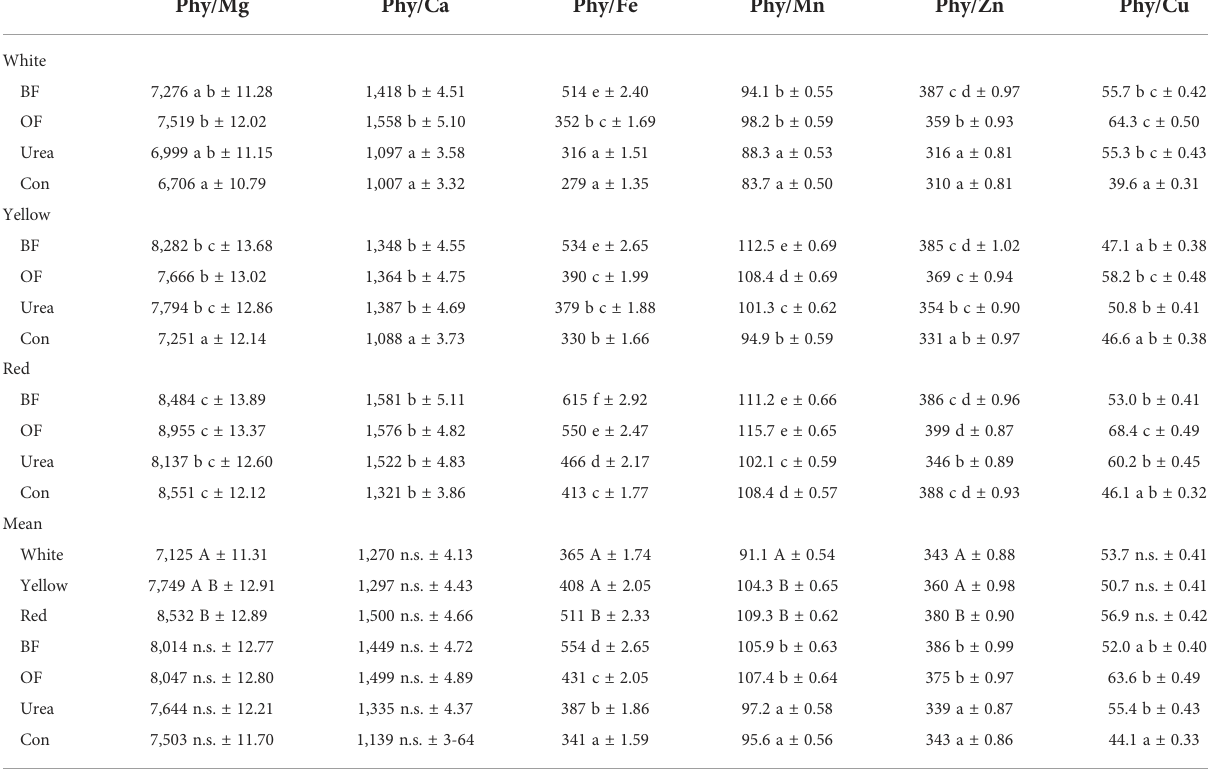
TABLE 6 Effect of different fertilizer treatments (biofertilizer (BF); organic fertilizer (OF); urea; control (Con; no fertilizer)) on the molar ratios between phytic acid (Phy) and essential elements, Phy/Mg, Phy/Ca, Phy/Fe, Phy/Mn, Phy/Zn, and Phy/Cu (average for 2018 – 2020). Phy/Mg Phy/Ca Phy/Fe Phy/Mn Phy/Zn Phy/Cu